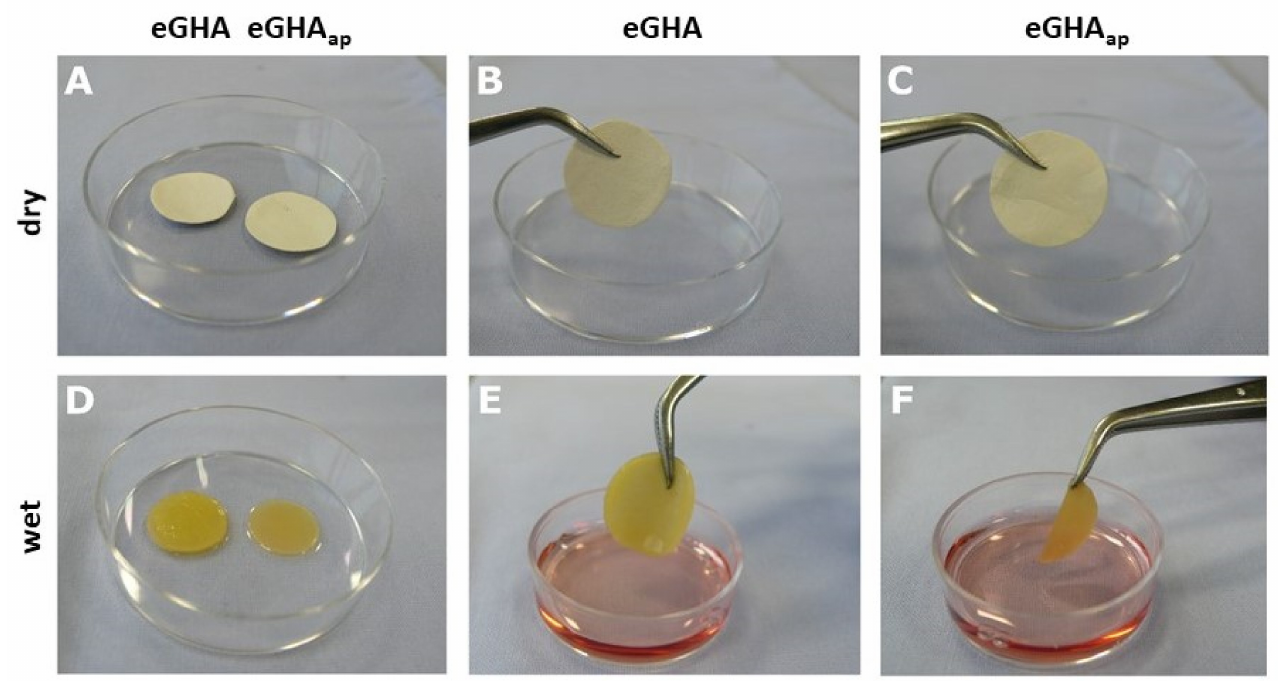
Figure 1. Photographs of electrospun gelatin/hydroxyapatite scaffolds with (eGHA ap ) and without additional porosity (eGHA). The scaffolds were punched in circles after drying ( A – C ) and subse- quently rewetted with culture medium ( D – F ). ( A – C ) If dry, there was no remarkable macroscopic difference between eGHA and eGHA ap (A, left: eGHA, right: eGHA ap ) apart from the slightly papery appearance of eGHA ap ( C ) when compared with that of eGHA ( B ). ( D – E ) Following wetting and moisture expansion, eGHA appeared clearly thicker ( D , left) and inherently more stable ( E ), while eGHA ap collapsed if taken with forceps ( F ) but remained in shape and easily unfolded if laid down ( D ,